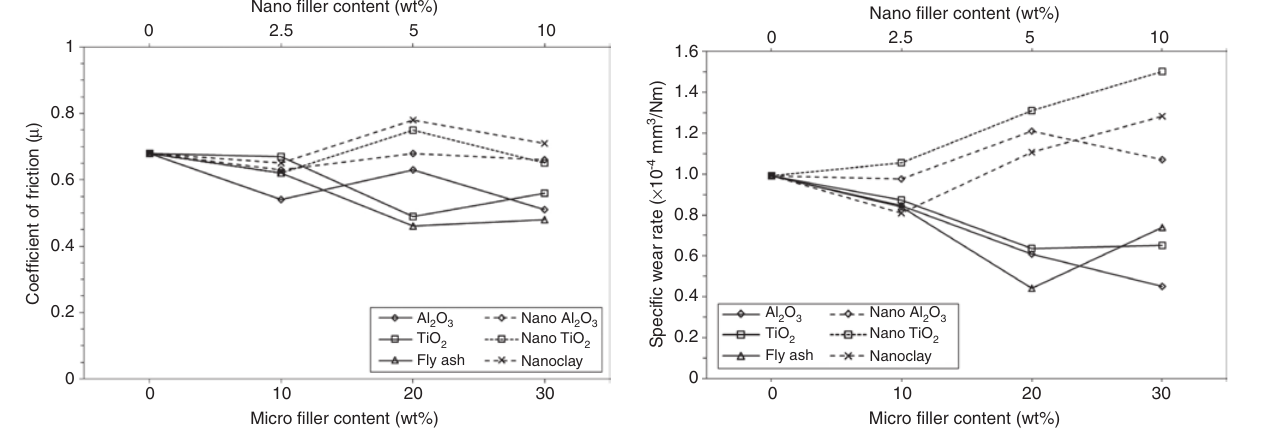
Figure 5: The variation of specific wear rate against filler content of micro- and nanoepoxy composites at 0.4 m/s sliding speed and 15 N load conditions.